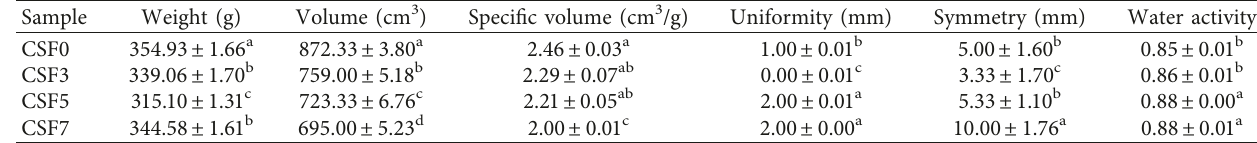
Table 4: Effect of replacing egg by chia seed flour (CSF) on cake quality parameters and water activity of cake.